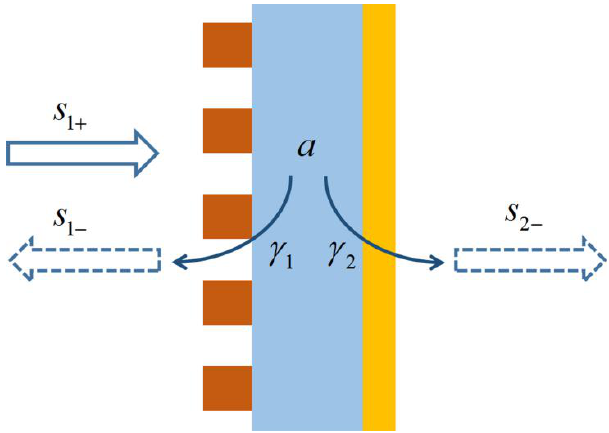
Figure 1. Single mode resonator with one-side input